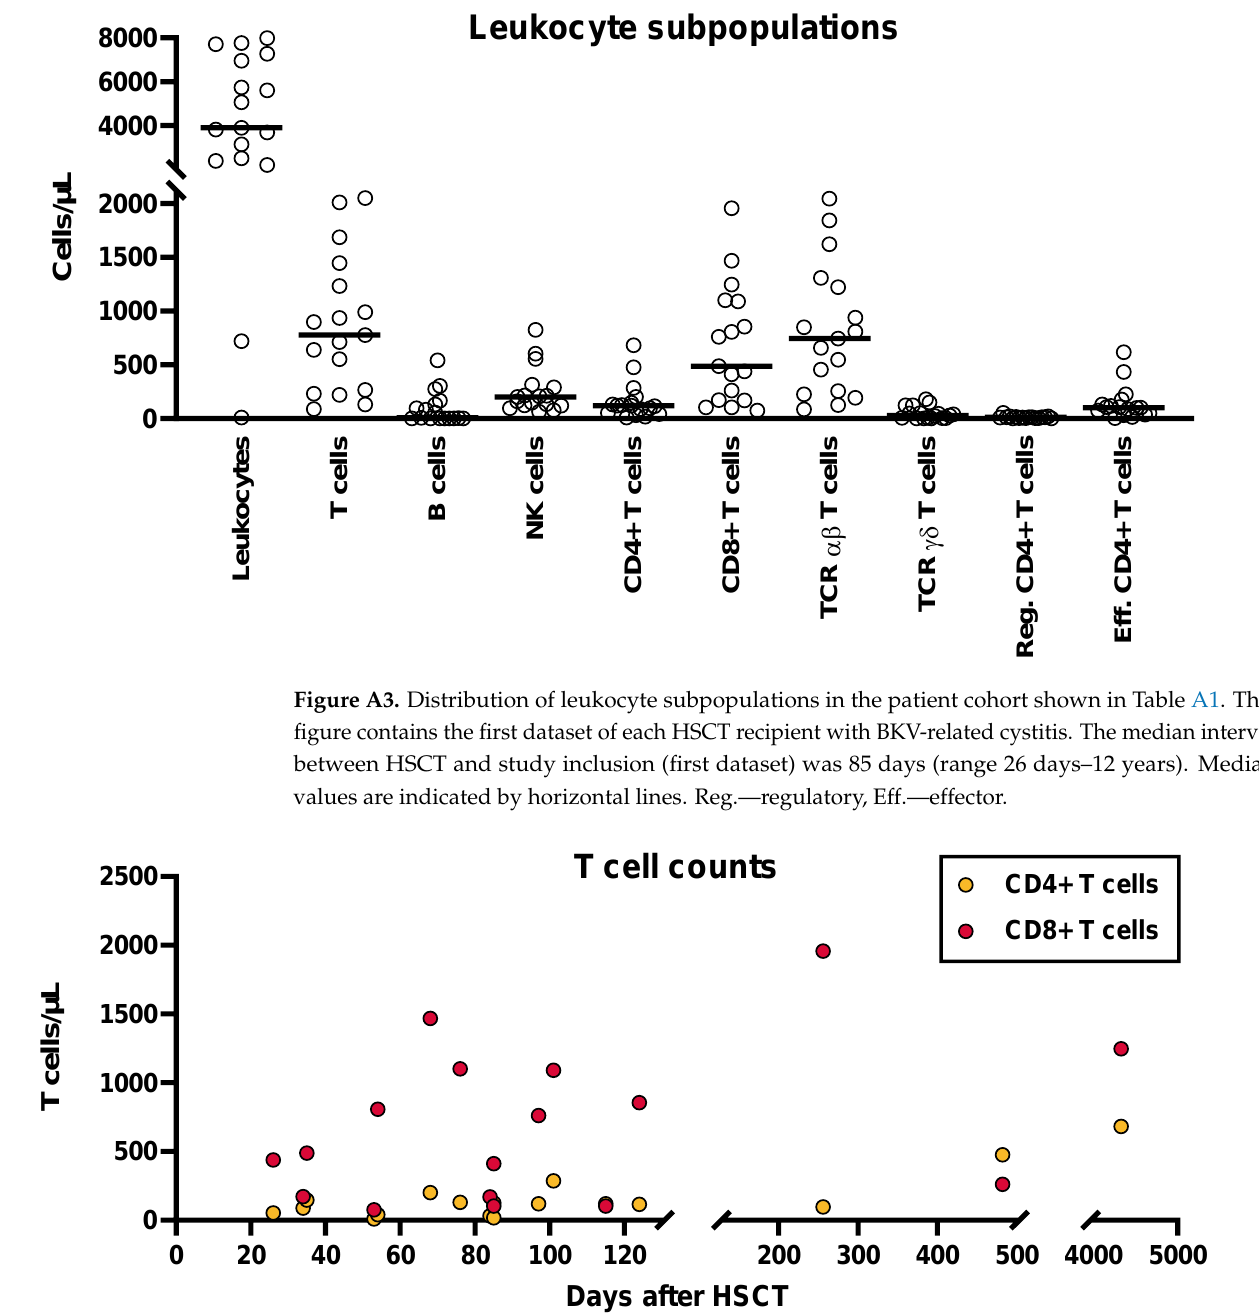
Figure A4. Correlation of the interval between HSCT and study inclusion (days after HSCT) and CD4+ and CD8+ T-cell counts in the patient cohort shown in Table A1. Spearman analysis indicated